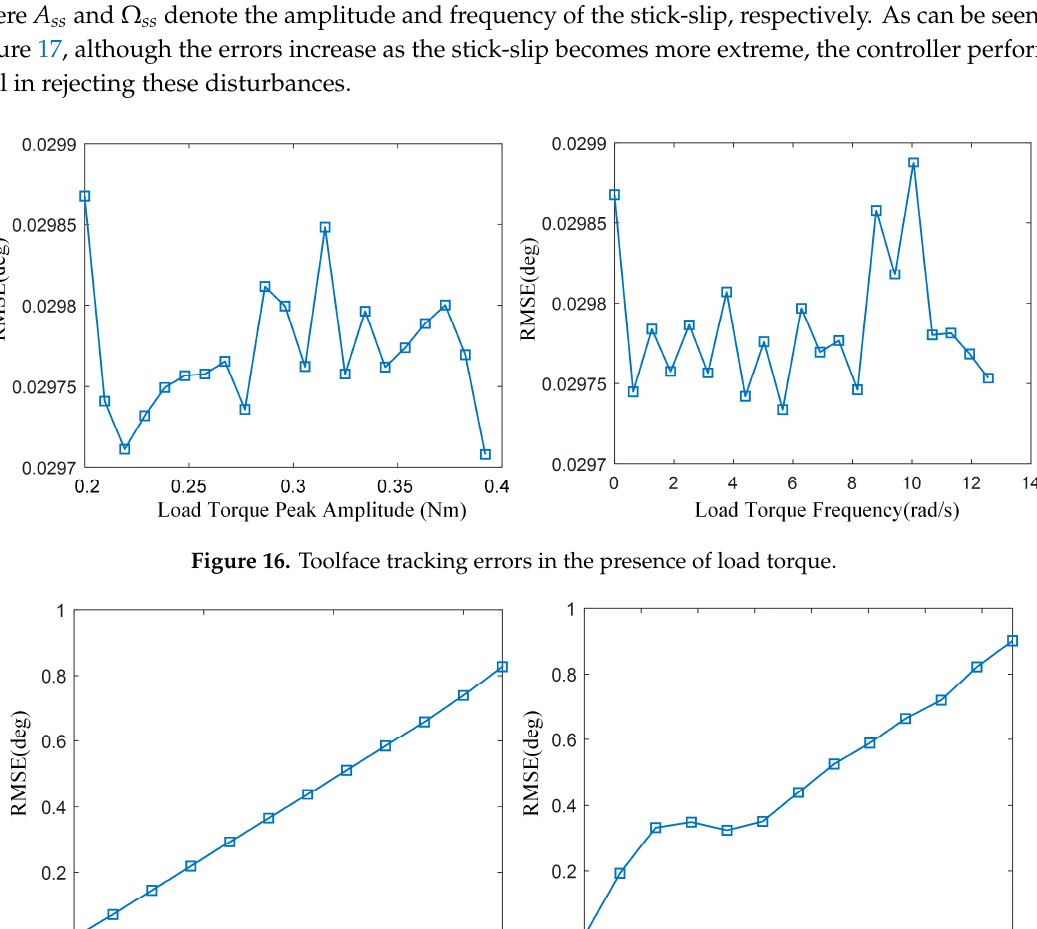
Figure 15. The toolface RMSE in the presence of parameter uncertainties. Figure 16 shows the toolface tracking RMSEs with various load torque disturbance, the possible load torque magnitude and frequency are varied based on (27), it is observed that the toolface is insensitive to the load torque variation. For the sake of simplicity, the sinusoidal wave shown in (30) was used to simulate stick-slip, and then, the toolface tracking RMSEs in the presence of outer housing speed disturbance were obtained: sin(